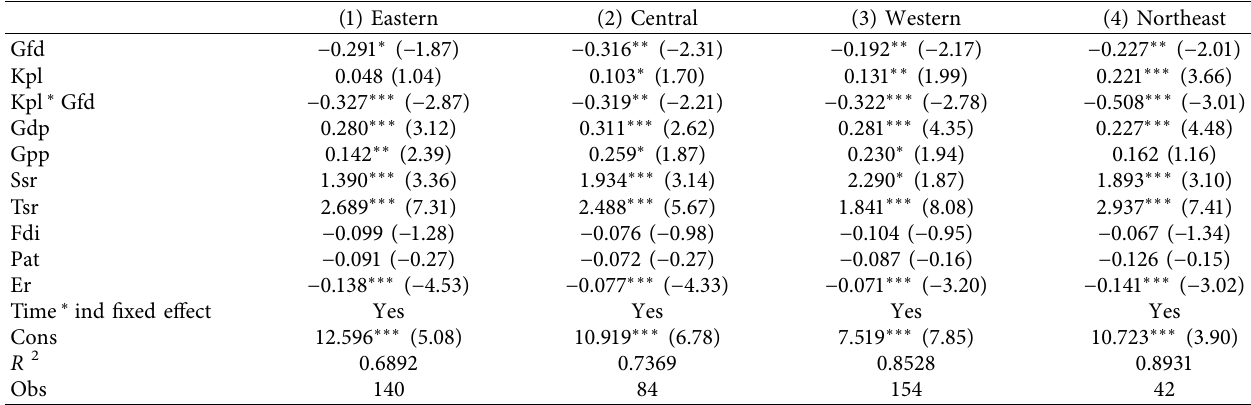
Table 6: Subregional regression results of regulatory effects.